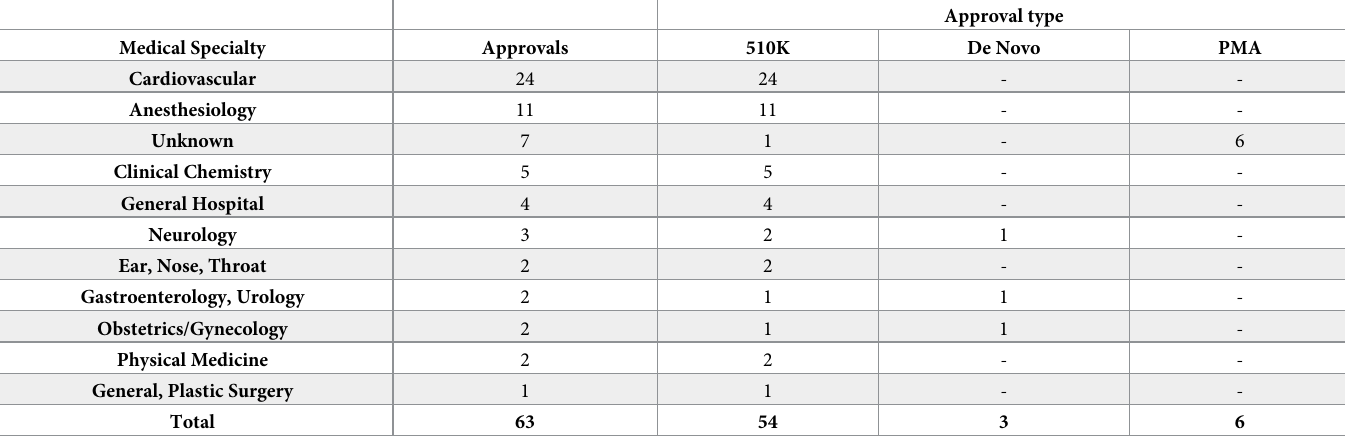
Table 1. Number of digital therapeutics extracted from openFDA device databases as of November 1, 2021, categorized by medical specialty (as reported by the FDA) and regulatory approval